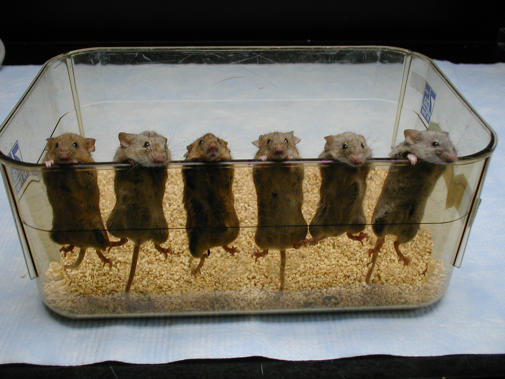
To model Parkinson disease, researchers bred mice with severe dopamine deficiencies that displayed rigidity, inhibited motion, and, as seen here, freezing behavior